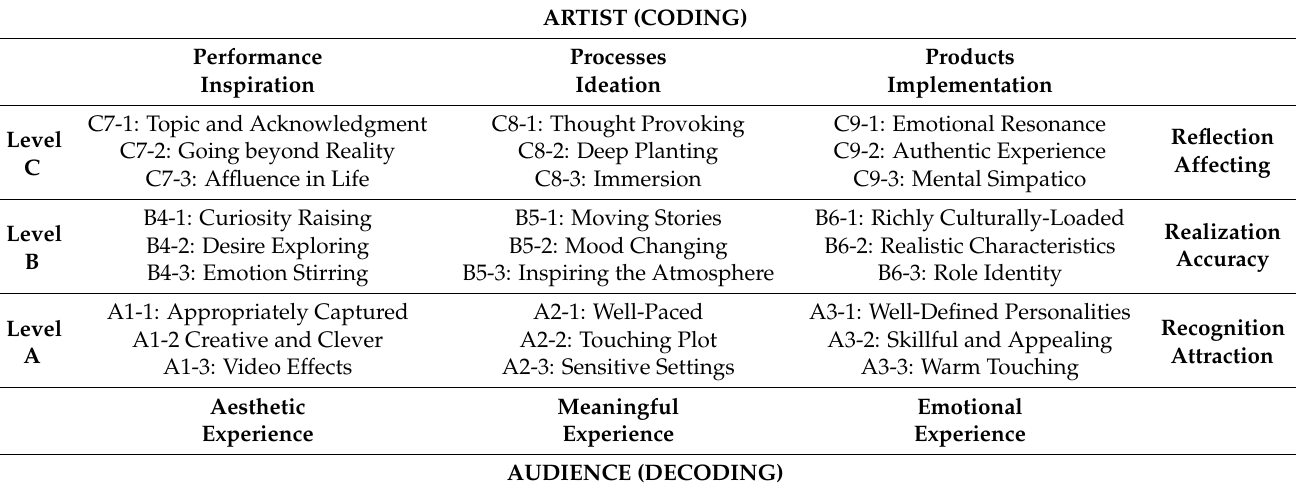
Table 1. The communication matrix for evaluating